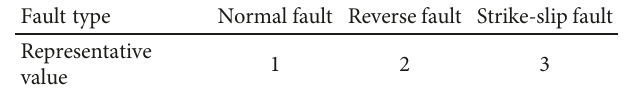
Table 1: Lithology classi fi cation.